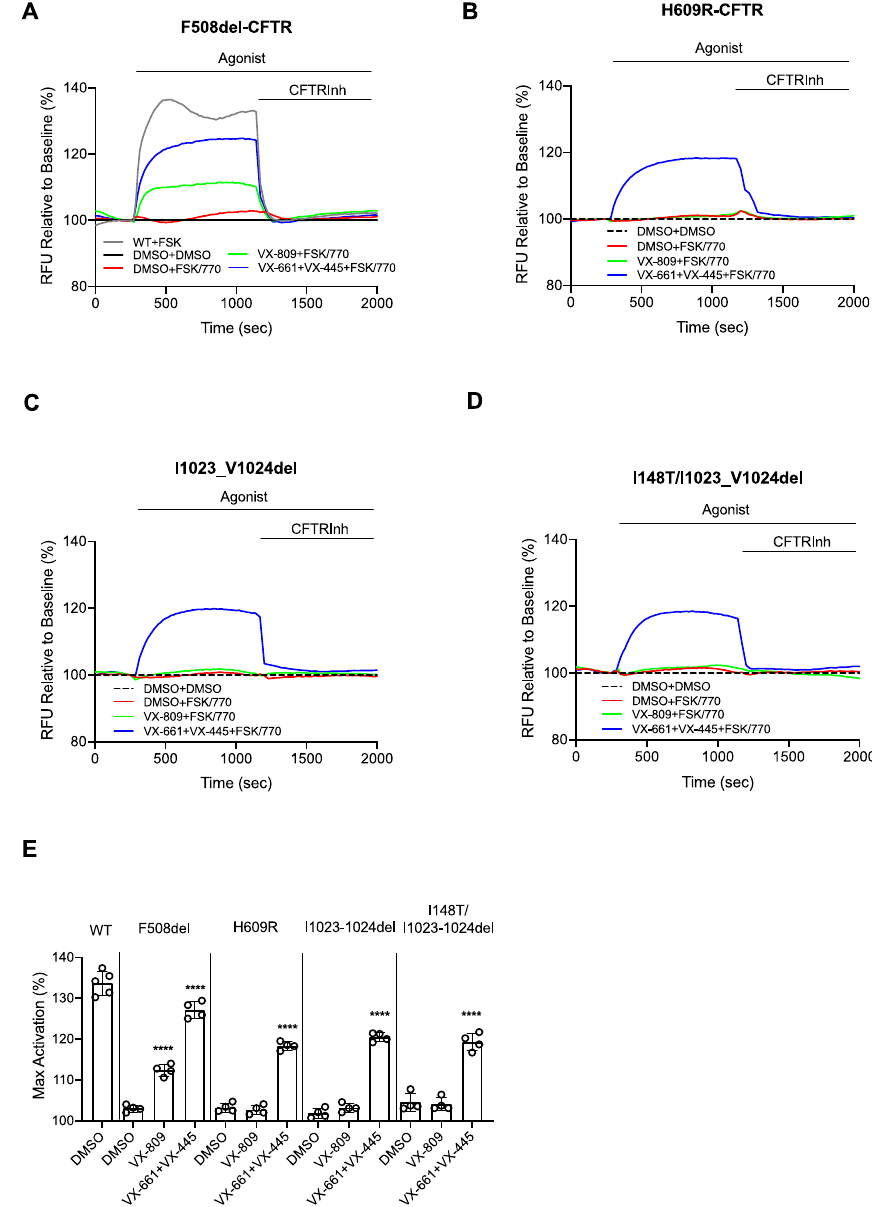
Figure 2. H609R and I1023_V1024del-CFTR are rescued by VX-661 + VX-445 + VX-770. HEK293 cells were transiently transfected with WT, F508del, H609R, I1023_V1024del, I148T/I1023_V1024-CFTR and treated for 24 h at 37 ◦ C with: DMSO (0.1%), 3 µ M VX-809 and 3 µ M VX-661 + 3 µ M VX-445. Representative traces of ( A ) WT and F508del, ( B ) H609R, ( C ) I1023_V1024del, ( D ) [I148T; I1023_V1024del]-CFTR function (membrane depolarization assay) in HEK293 cells. ( E ) Bar graphs show the mean ( ± SD) of maximal activation of mutated CFTR after stimulation by 10 µ M FSK +1 µ M VX-770 in H609R, I1023_V1024del, I148T/I1023_V1024-CFTR HEK293 cells and 10 µ M FSK in WT-CFTR HEK293 cells ( n = 4 biological replicates and 4 technical replicates for each experiment). (**** p <